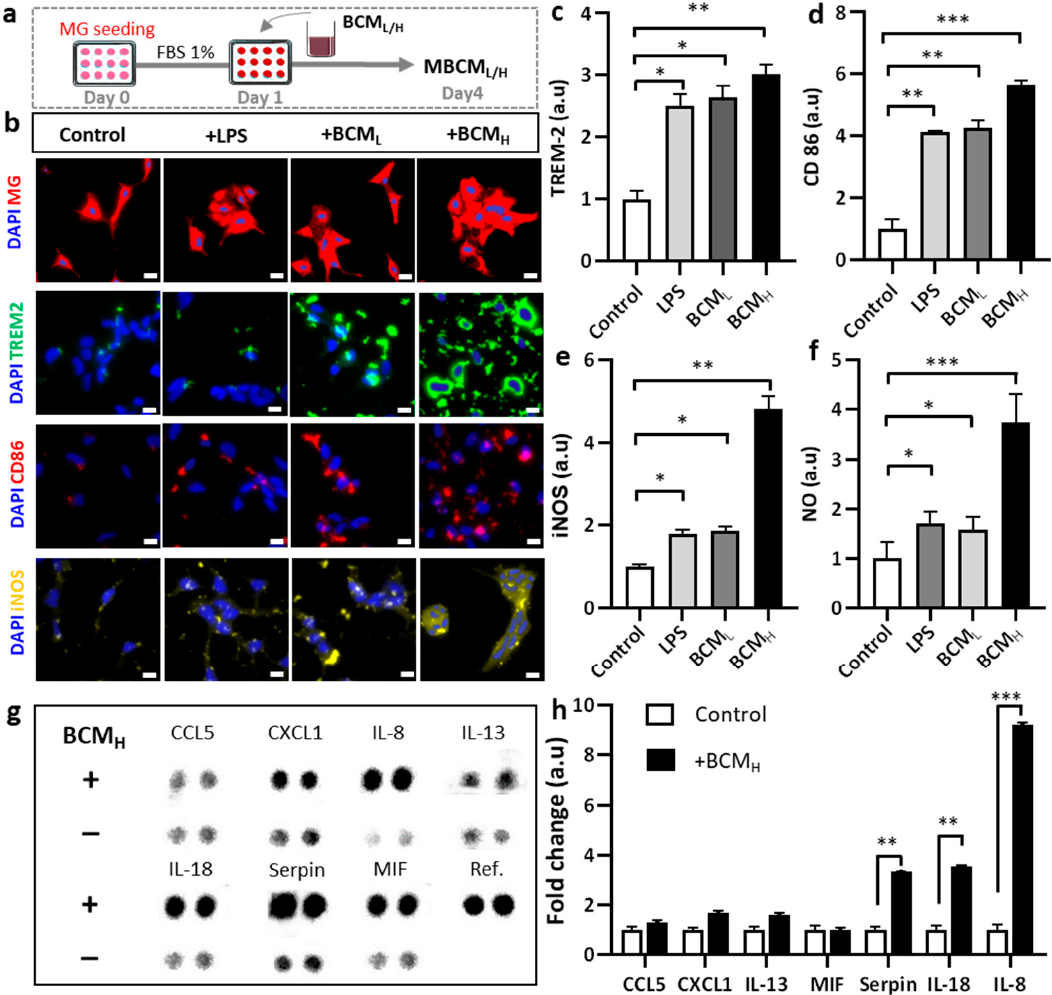
Figure 2. Assessment of neuro-inflammation trigged by bacterial conditioned media at two different concentrations. ( a ) Schematic diagram showing experimental timeline for neuro-inflammation assessment. ( b ) Morphological changes and immunostaining images against CD86, TREM-2 and iNOS markers of microglia cells treated with 10 ng/mL LPS, [1 BCM L :10 MM] and [1 BCM H :10 MM] in a single-culture system at day 4, scale bar 50 um. ( c – e ) Quantification of TREM2, CD86 and iNOS fluorescent intensity expressed by stained microglia cells. Significant differences among BCM L , BCM H and LPS treatment, compared with the control. ( f ) Analysis of the amount of nitric oxide released by microglia cells. ( g , h ) Quantification of chemokines and cytokines released in microglia-stimulated conditioned media indicated increased inflammatory response from microglia cells, compared with the control. All experiments were repeated three times independently and statistically analyzed by One-way ANOVA followed by Tukey HSD test (* p < 0.05, ** p < 0.01 and *** p < 0.001). All data were presented as mean ± standard deviation